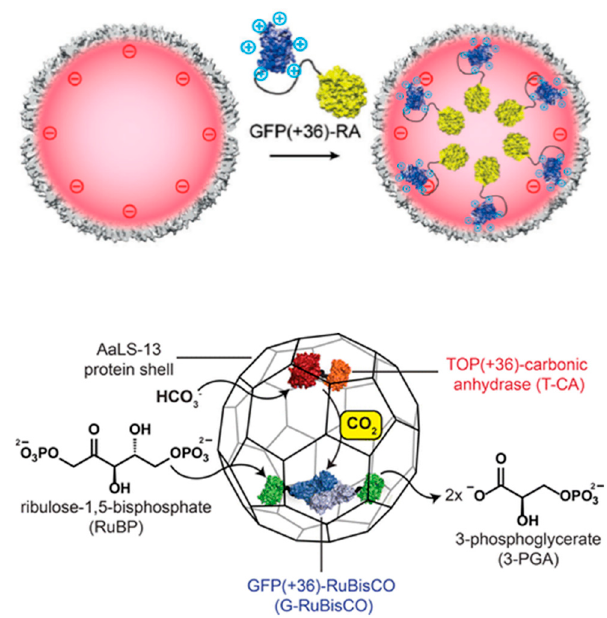
Figure 10. The AaLS-13 shell as a designer nanocage for hosting foreign enzymes. ( A ) Fusion of retro-aldolase (RA) to GFP(+36) allows encapsulation of the enzyme by AaLS-13. Reprinted from Hilvert and co-workers [121]. Copyright 2018 Royal Society of Chemistry. ( B ) Repurposing of AaLS-13 into a carboxysome mimic. Reprinted from Hilvert and co-workers [125]. Copyright 2016 American Chemical Society.